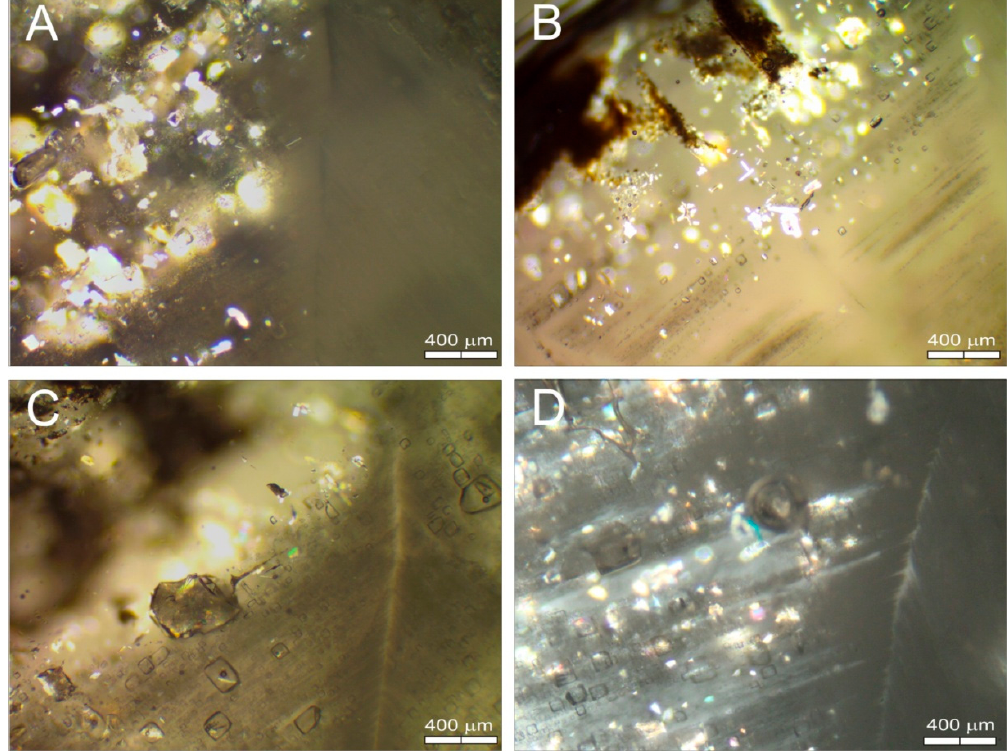
Figure 7. Small crystals of calcium sulfate in sedimentary halite (high interference colors in crossed polars). Crystals in halite are represented by anhydrite, and within fluid inclusions by gypsum, bassanite, and anhydrite [37]. ( A – C )—Transcarpathian Basin, Badenian, Mukachevo, Well 6-T, depth interval: ( A )—1047–1050 m; ( B )—1314–1318 m; ( C )—1047–1050 m; ( D )—Transcarpathian Basin, Badenian, Solotvyno Salt Mine, sample no. 29.